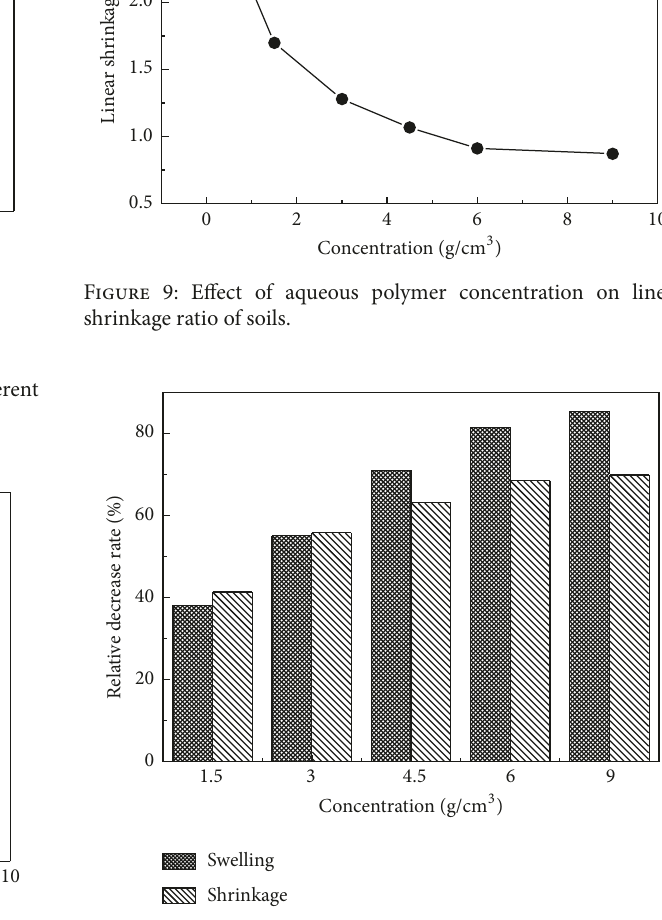
Figure 10: Relative decrease of LSWR and LSHR in different polymer concentration